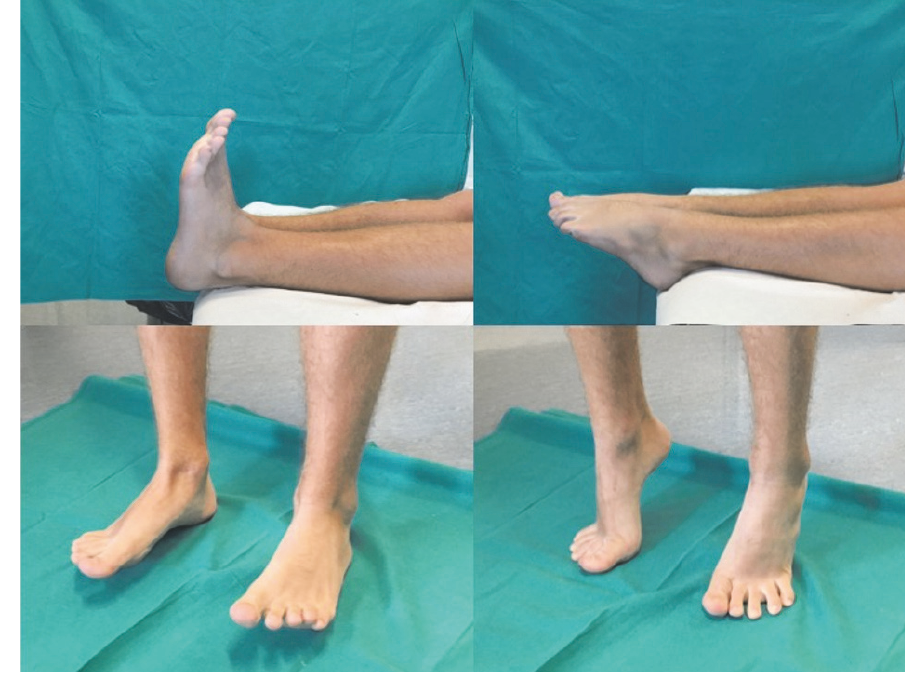
Figure 5: Clinical examination at the 5-year